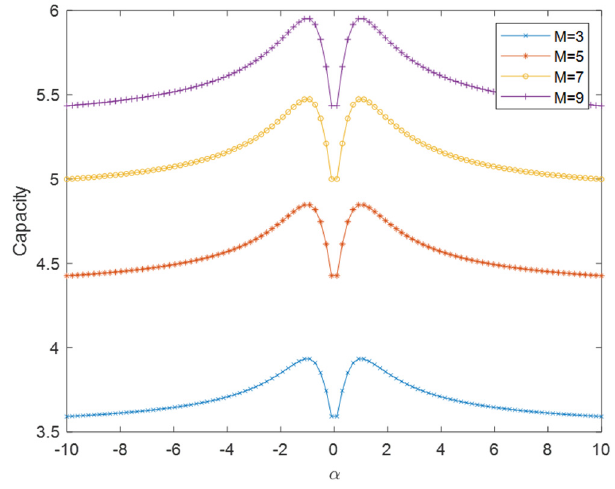
Figure 6. Channel capacity of the link with the coaxial double-position power Gaussian vortex carrier versus dimensionless parameter | α | = 1 for different channel numbers